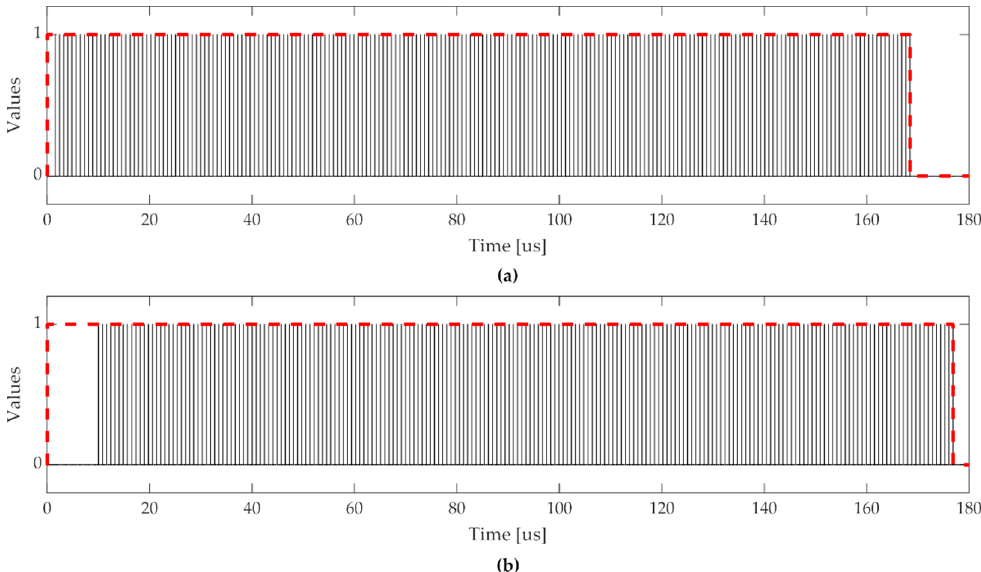
Figure5. KernelperformanceinSimulinksimulations: ( a )Kernelwithproposedaccumulator, ( b )Kernel Figure 5. Kernel performance in Simulink simulations: ( a ) Kernel with proposed accumulator, ( b ) with Simulink IP accumulator. Kernel with Simulink IP accumulator.